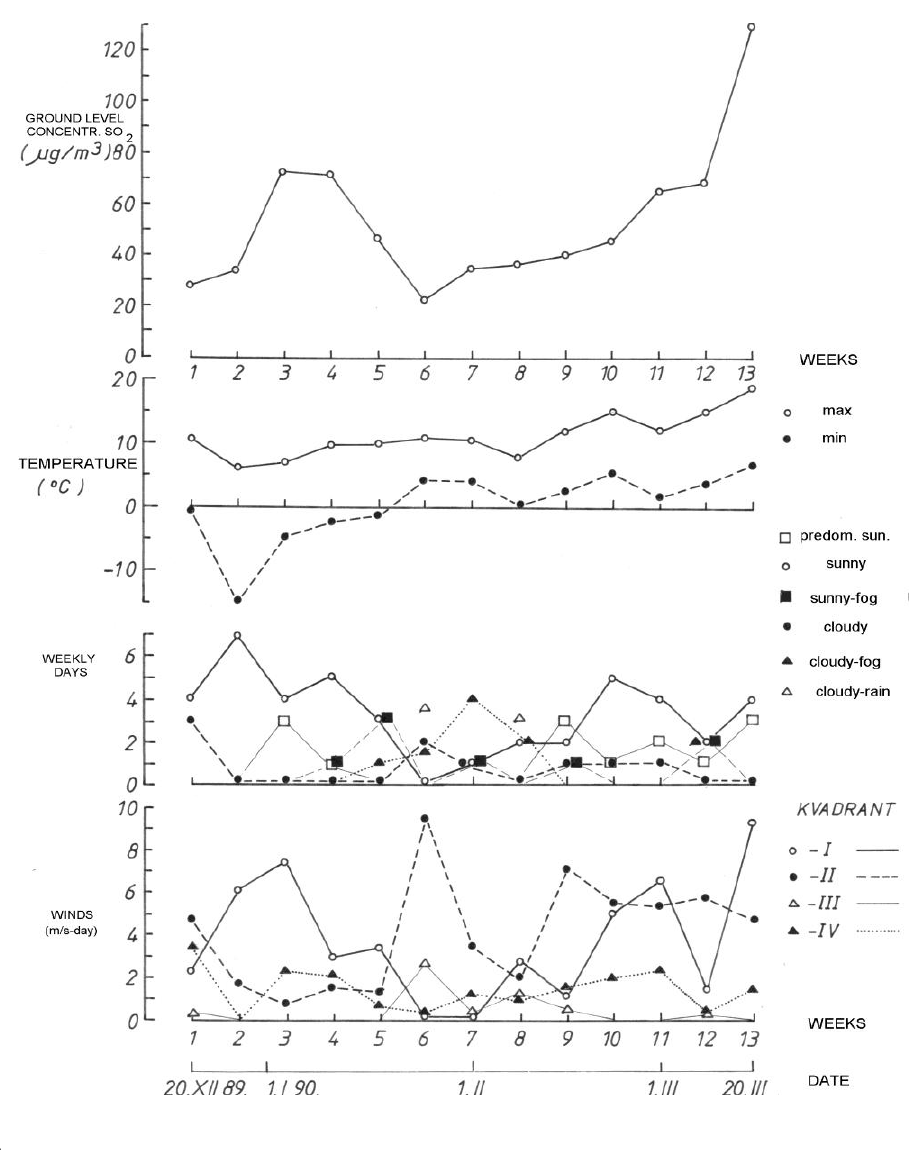
Figure 3. Weekly ground-level concentrations of SO minimum temperatures (C°), weather conditions and wind conditions during the exposure